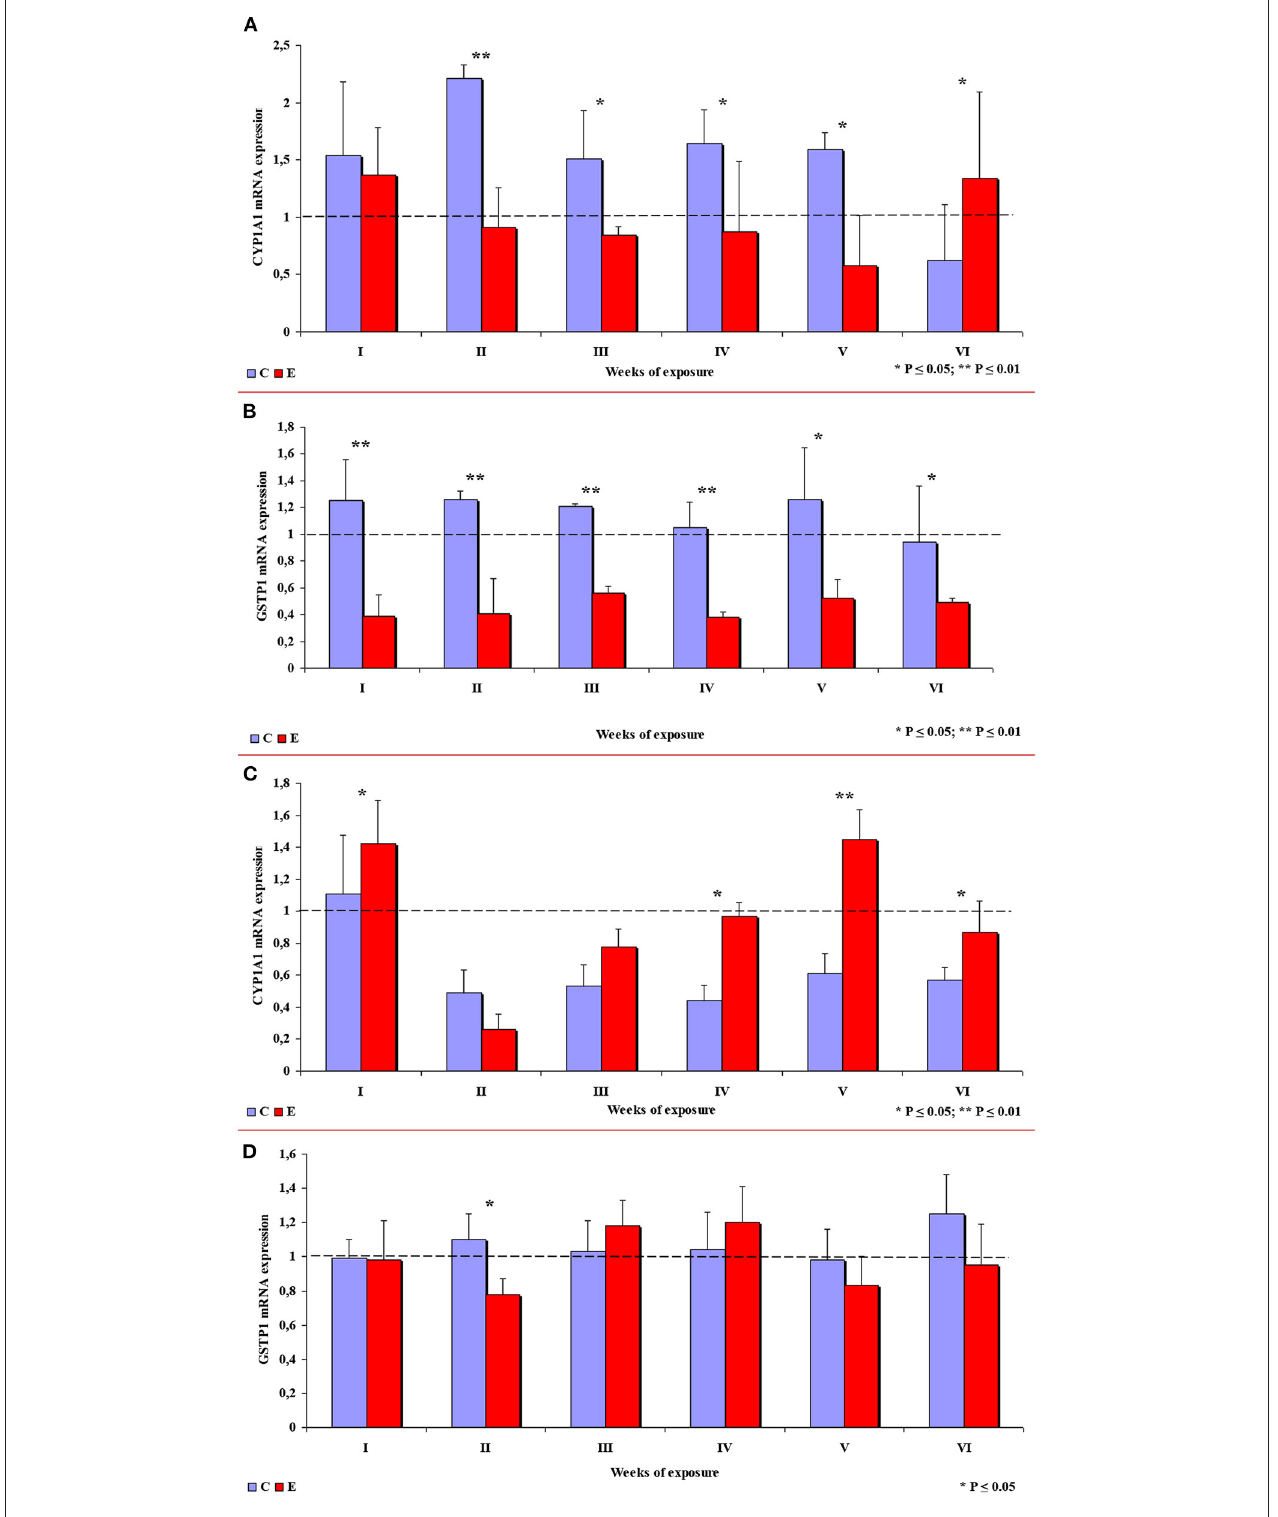
FIGURE 9 | The expression of selected enzymes in the colon in different weeks of exposure: (A) CYP1A1 m RNA expression in the ascending colon; (B) GSTP1 m RNA expression in the ascending colon; (C) CYP1A1 m RNA expression in the descending colon; (D) GSTP1 m RNA expression in the descending colon. The bars represent mean values ( n = 3) of enzyme gene expression ratios (ER ± SE) relative to a control sample at the beginning of the experiment (ER = 1.00; dashed line). Symbols (*) indicate experimental (E) groups that showed significantly different m RNA levels compared to a respective control (C) group (* P ≤ 0.05, ** P ≤ 0.01).